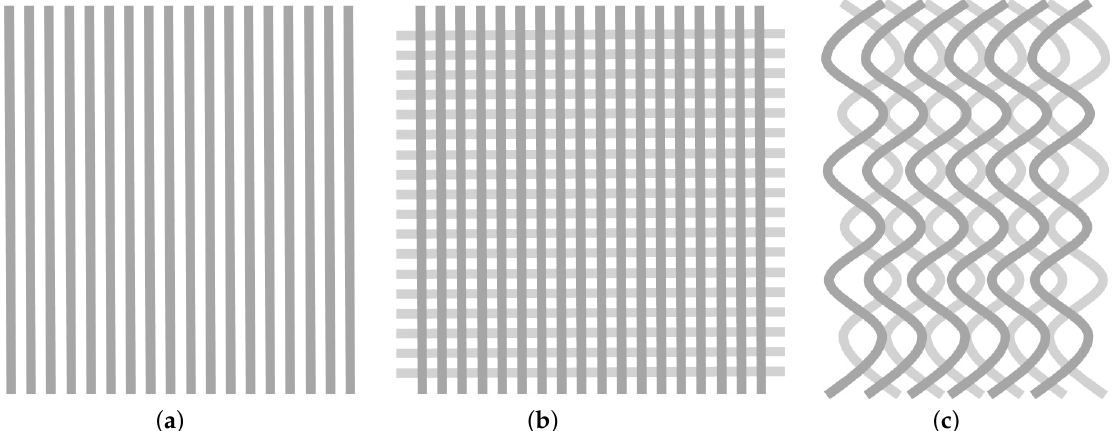
Figure 5. Sketch of common channel configurations for visualization of the contact area: ( a ) parallel, superimposed; ( b ) parallel, criss-crossed; and ( c ) wave-like,